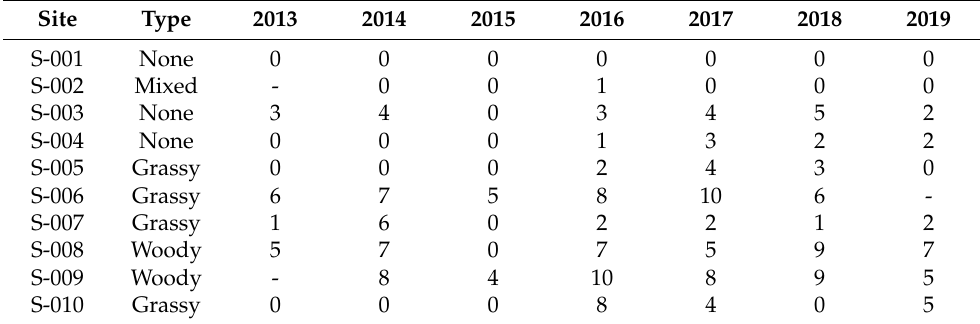
Table 3. Shoreline vegetation type (Type) and yearly aquatic macrophyte richness at sampling sites for a shoreline seine survey on the St. Clair and Detroit rivers. “-” indicates no data. Sites are arranged from upstream to downstream (top to